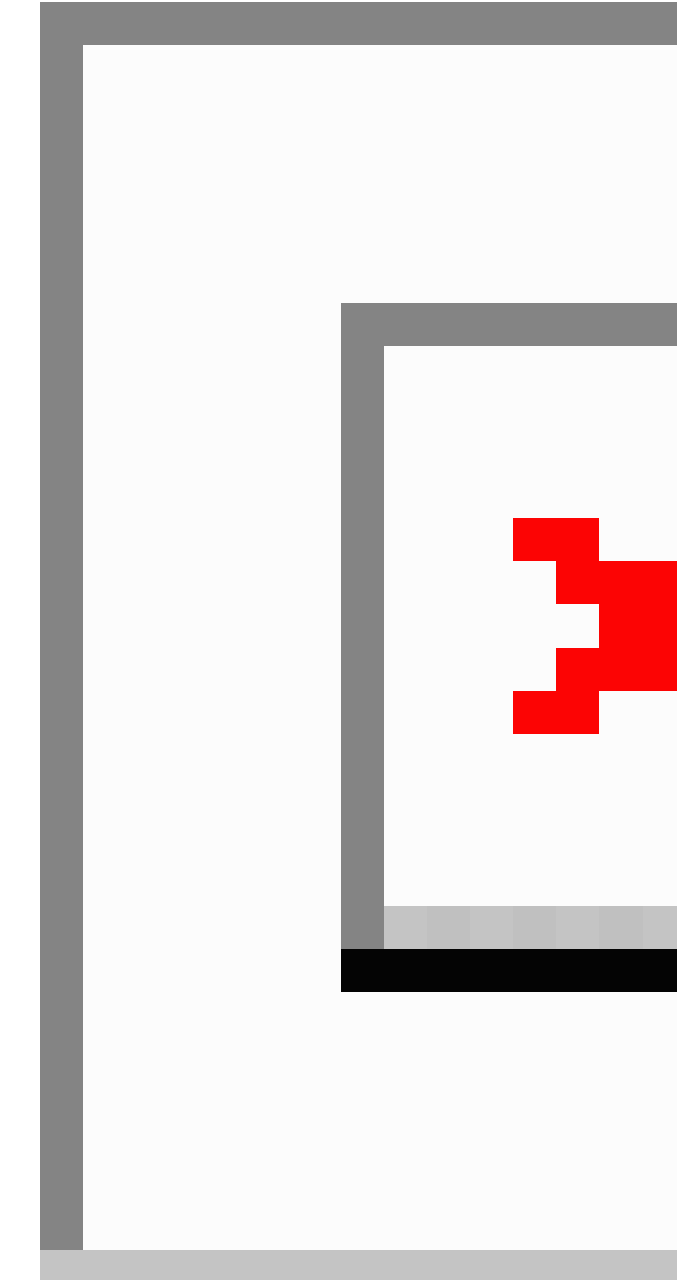
Figure 4. View Results window for the FAIR Concept